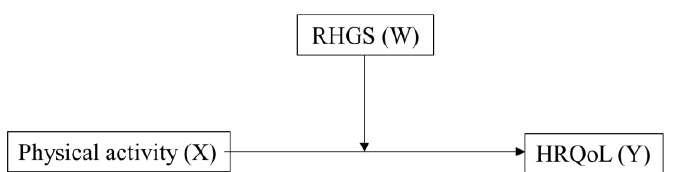
Figure 2. The relationship between physical activity (X) and health-related quality of life (HRQoL, Y) moderated by relative handgrip strength (RHGS, W).